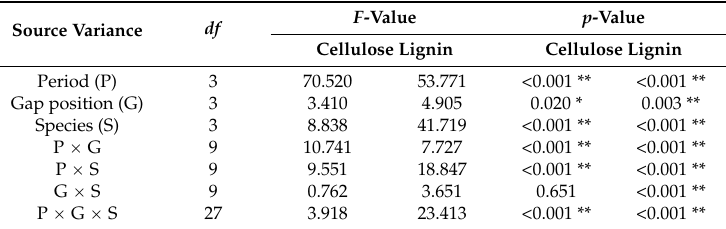
Table 3. Multivariate analysis of variance (MANOVA) for the effects of period, gap position and species on litter cellulose and lignin absolute change daily rates over the first year of litter decomposition in an alpine Minjiang fir forest. df , degree of freedom.